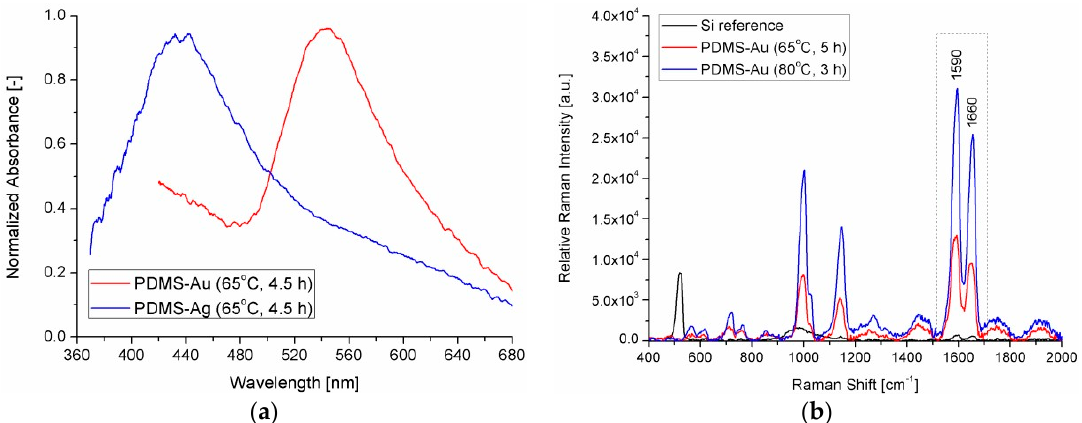
Figure 3. ( a ) Normalized absorbance spectra of two PDMS-Ag/Au samples prepared at an increased incubation temperature of 65 °C for the SERS experiments. ( b ) Raman (Si reference) and SERS (PDMS- Au nanocomposites) spectra of the of the benzophenon-isopropyl alcohol test solution measured with 488 nm